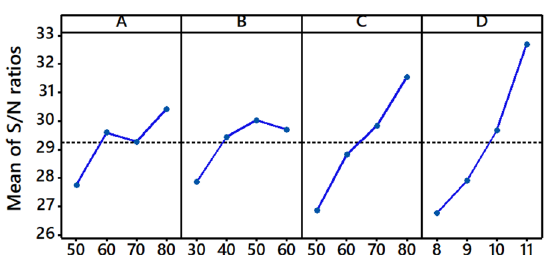
Figure 4. Main effects plot for S/N ratios (data means) in T% of